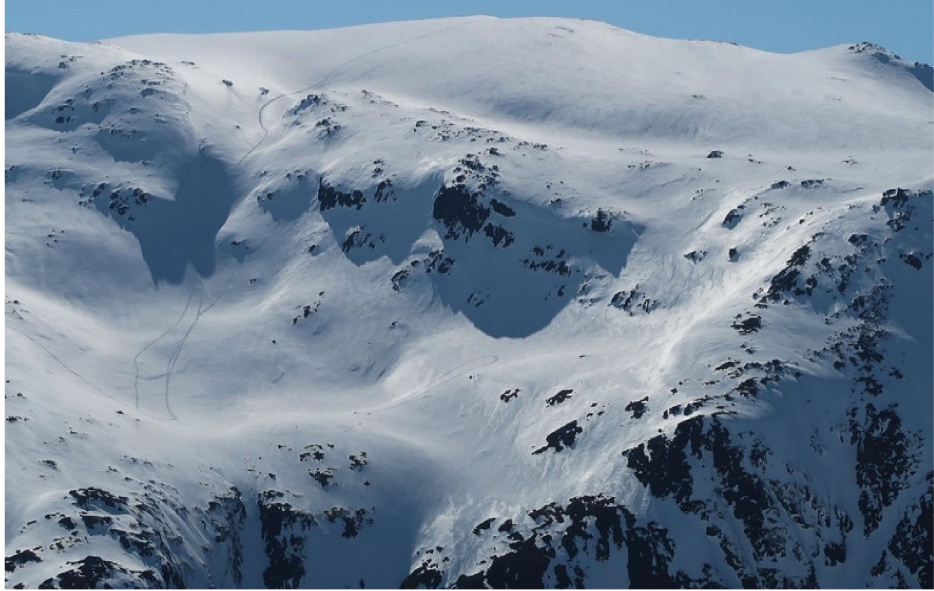
Figure 1. Typical terrain used for high-marking and hill climbing. Photo: Courtesy of participant.